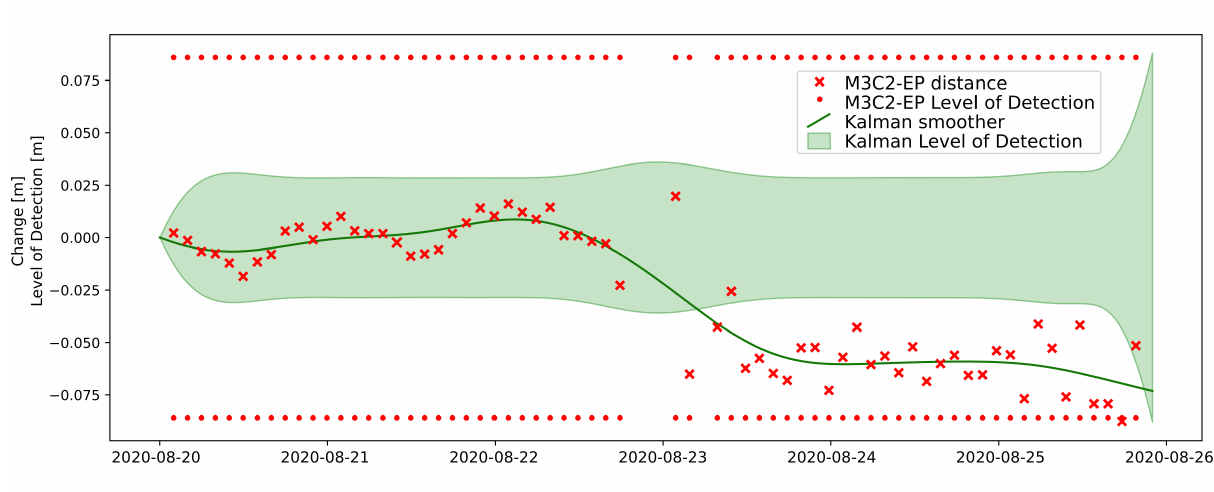
Figure 3. Example time series of an erosion form. The location corresponds to the rill marked ’III’ in Figure 10. The Kalman smoother result averages out daily patterns, yet still closely corresponds to the change form. At the end of the acquisition period, the uncertainty in the Kalman smoother (here represented by the Level of Detection at 95% significance) increases, as no future measurements are available.